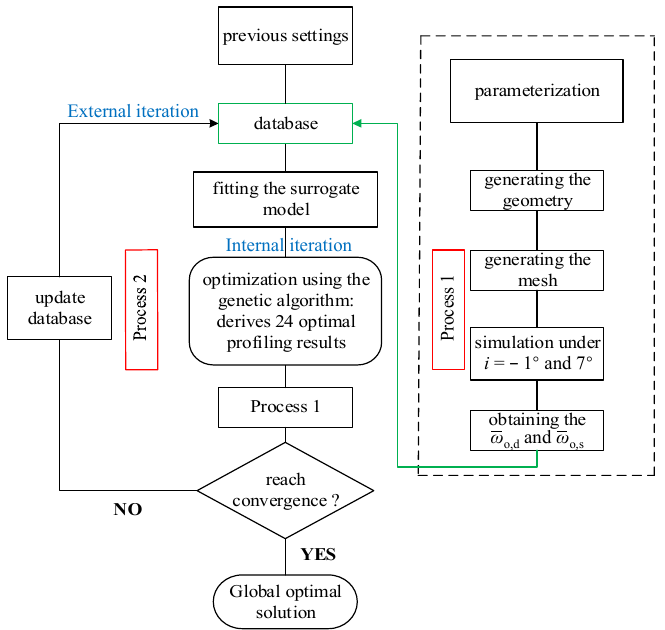
Figure 7. The framework of the auto-optimization design.